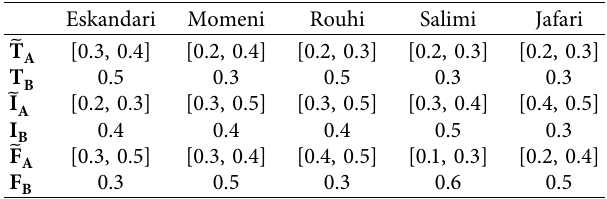
Table 3: Employee